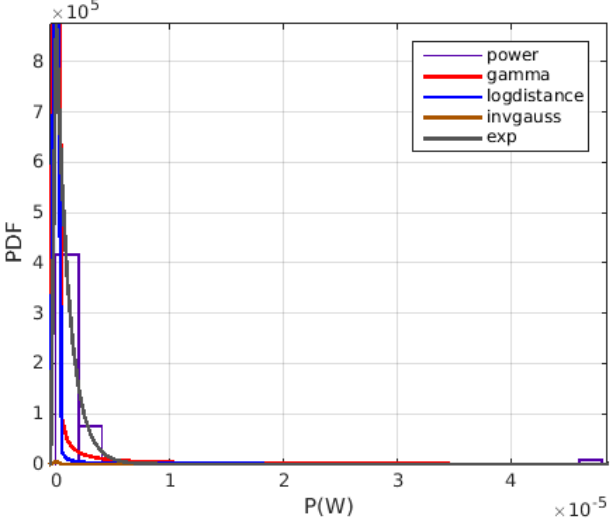
Figure 3. Probability Density Function (PDF) of average power measurements (W) for LoRa SF12 at a distance of